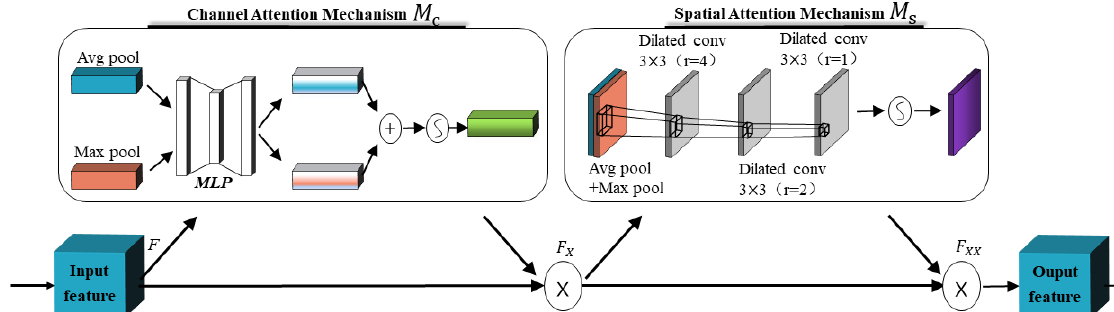
Figure 4. Dilated CBAM module.